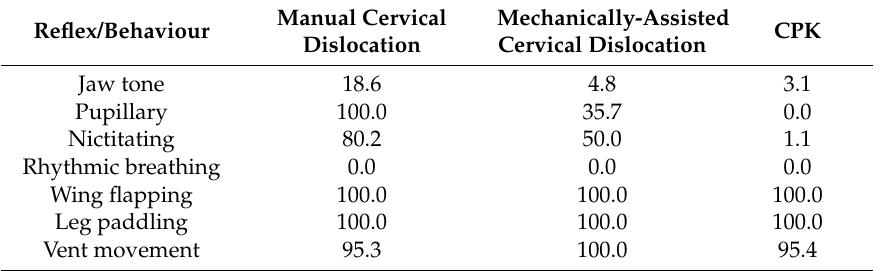
Table 2. Proportion (%) of birds displaying reflexes/behaviours post successful method application at any time for both cervical dislocation methods (manual cervical dislocation and mechanically-assisted cervical dislocation) and the captive bolt